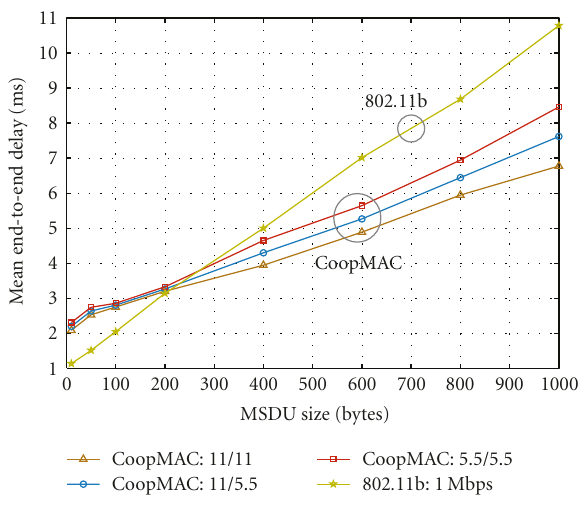
Figure 10: Mean end-to-end delay.